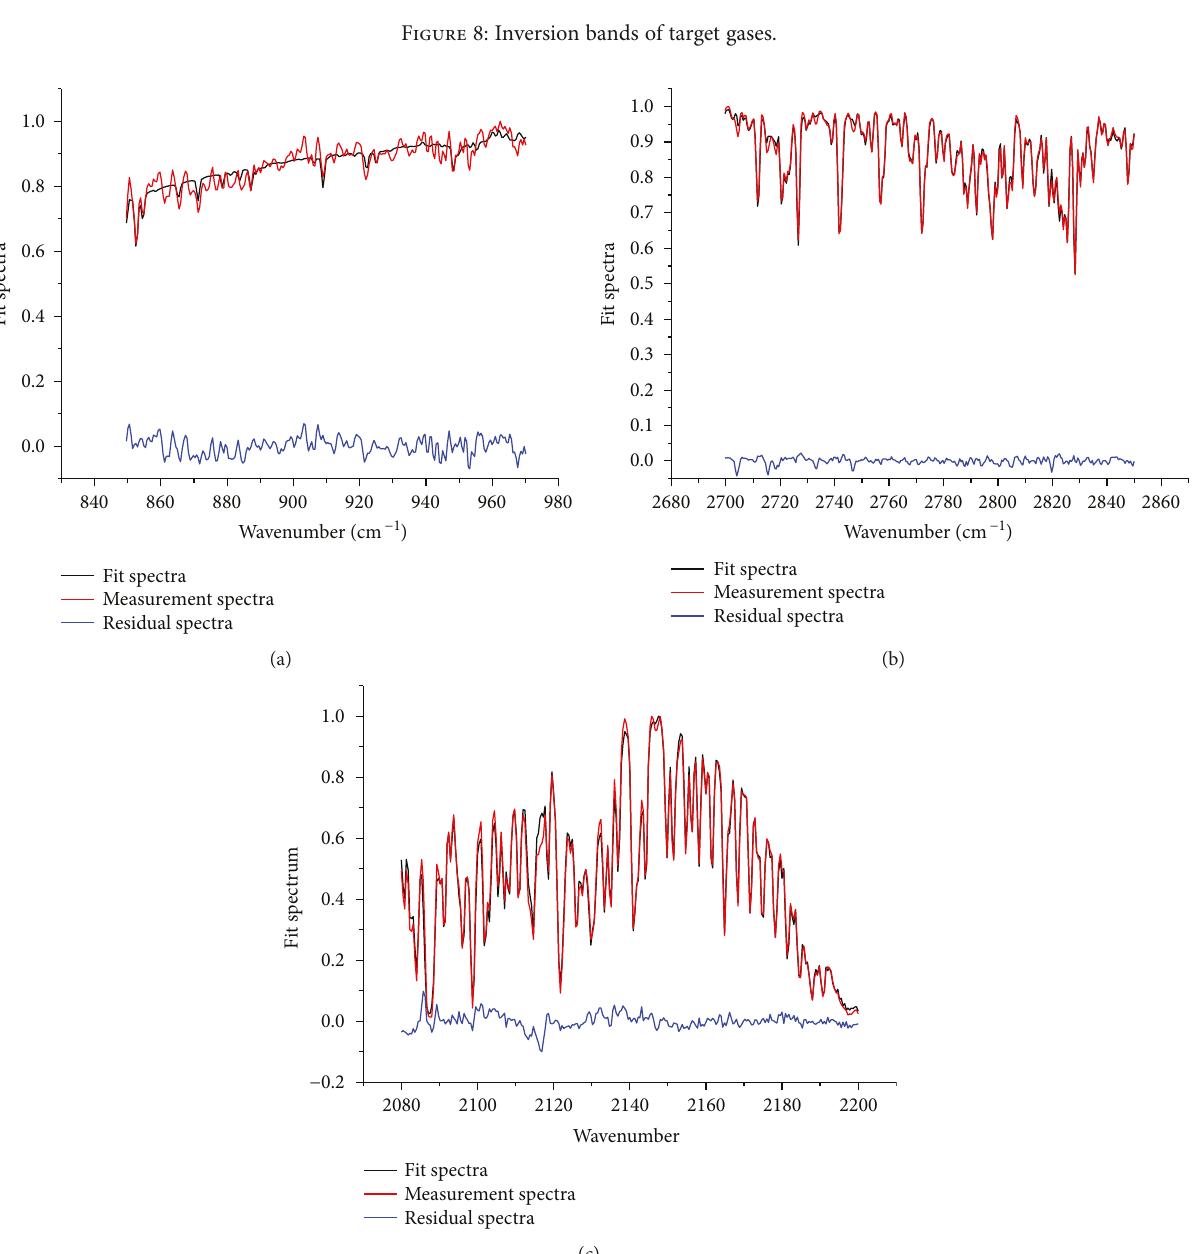
O, and (c) the fi tting result of CO and CO 2